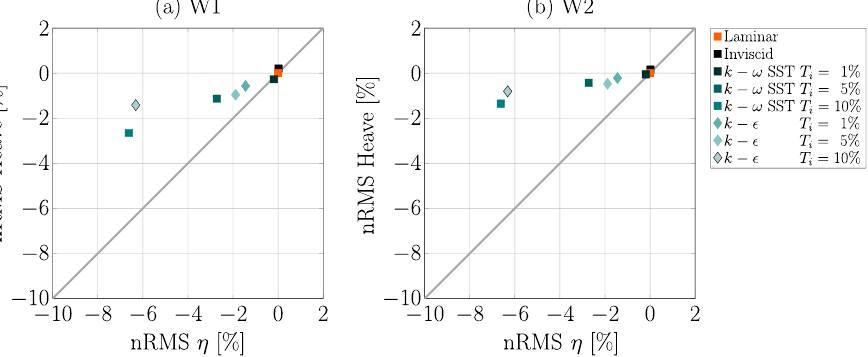
Figure 9. nRMSD of the heave displacement over the nRMSD of the free surface elevation for ( a ) W1 and ( b )